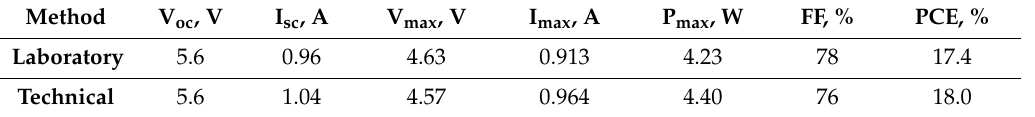
Table 1. Photovoltaic parameters of PV module investigated by laboratory and technical setup.